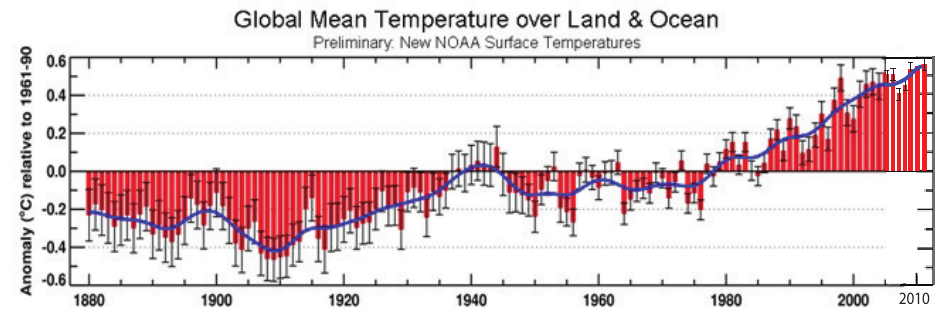
Figure A1. Changes in global mean surface temperature relative to 1961–2013 (source: